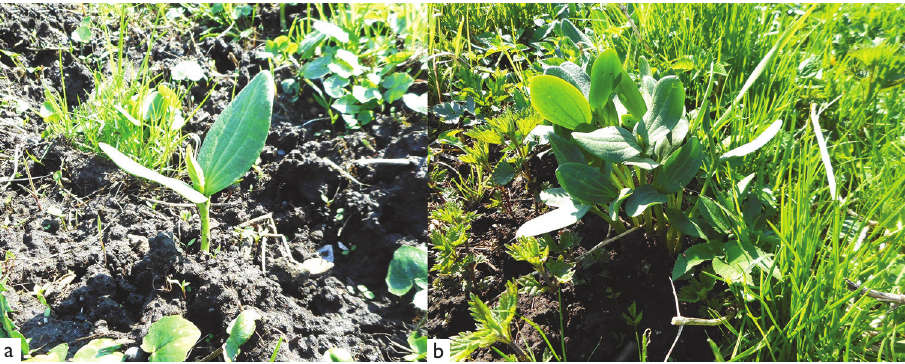
a Figure 1. Seedlings of E. lobata most commonly occur as a single individuals but also can be found in b tight clusters, suggesting seed caches.